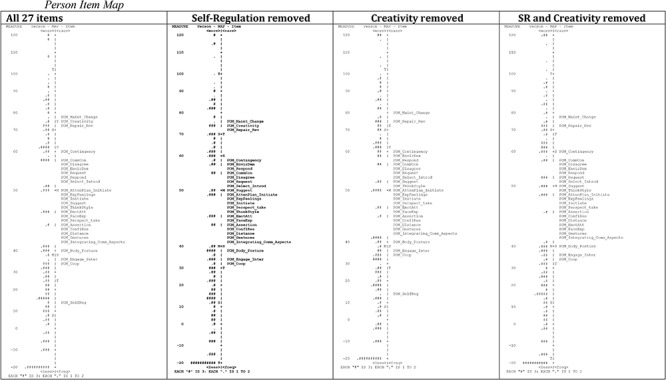
Person item map.